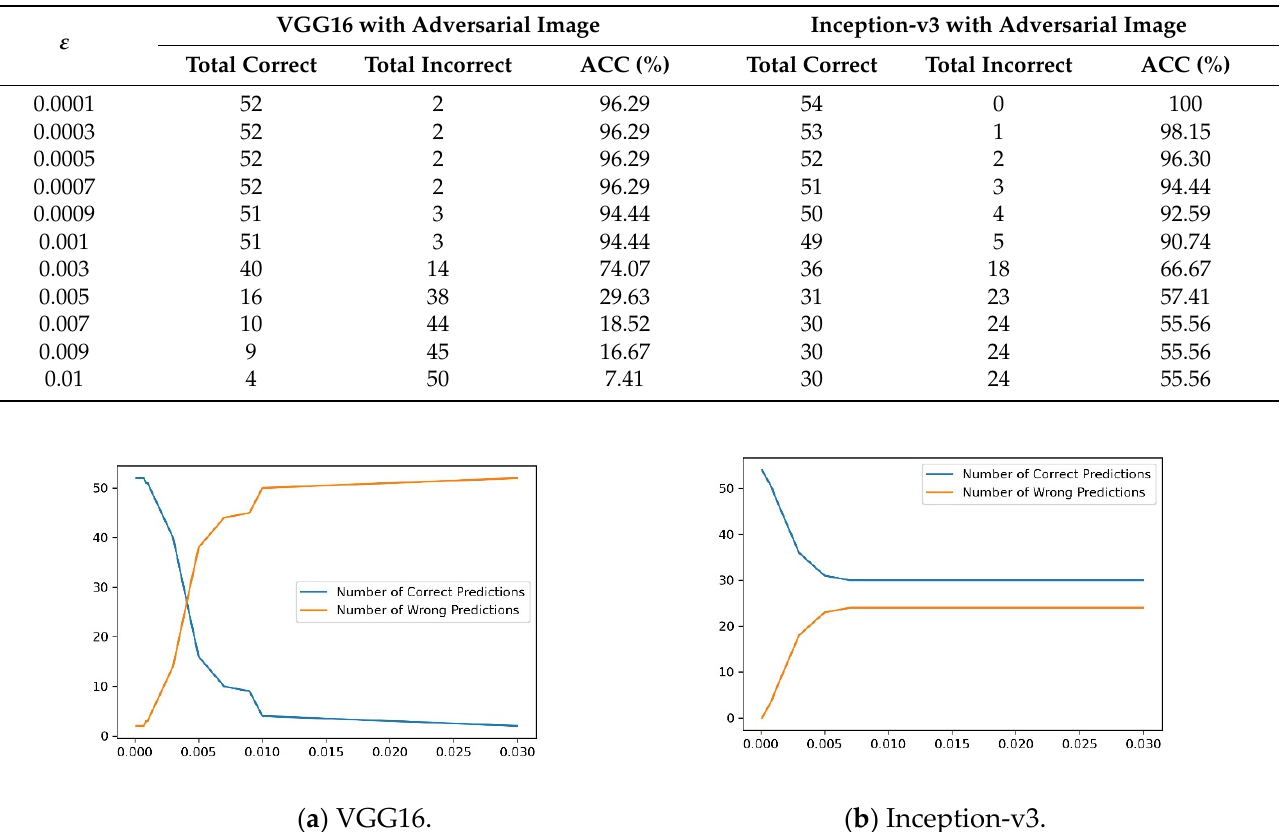
Table 4. Diagnostic performance drop for different ε of FGSM attack in chest X-ray images. VGG16 with Adversarial Image